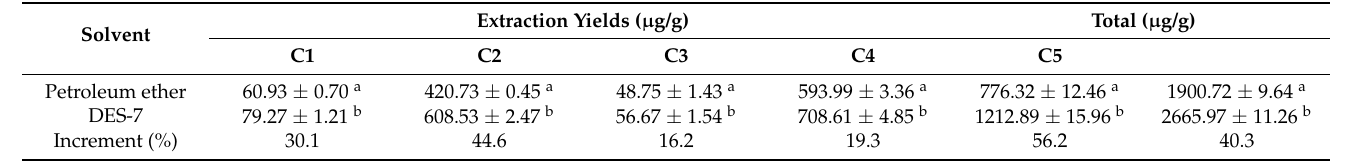
Table 4. Comparison of extraction yields ( µ g/g) between petroleum ether and DES-7 for the five macamides.